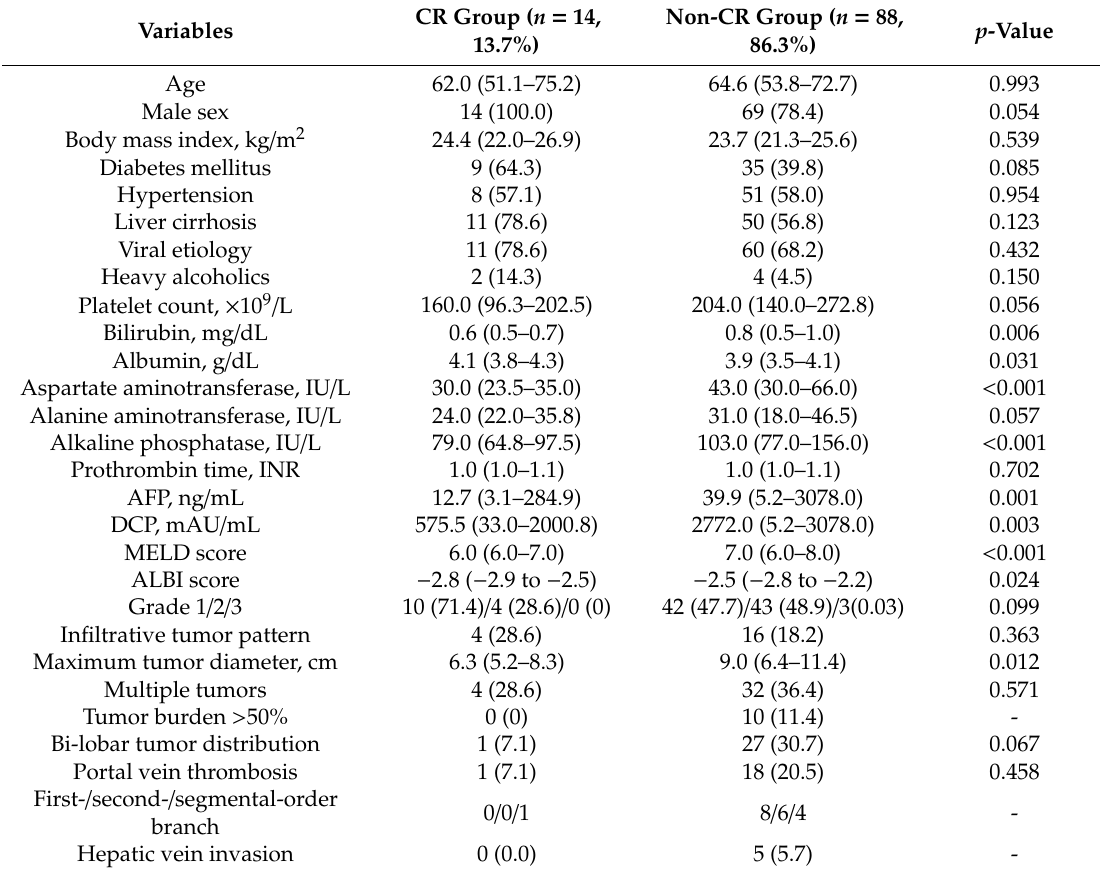
Table 2. Comparison between patients who achieved complete response (CR) and those who did not.